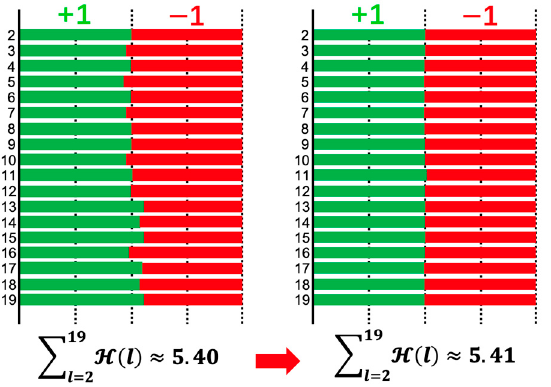
Figure 2. The distributions of network weights’ binary representations ( ± 95% confidence interval) without ML ( left ) and with ML ( right ) in binary pre-activation XNOR-Net/ResNet-20 are illustrated. The models are trained with λ = 10 − 4 on the CIFAR-10 dataset.